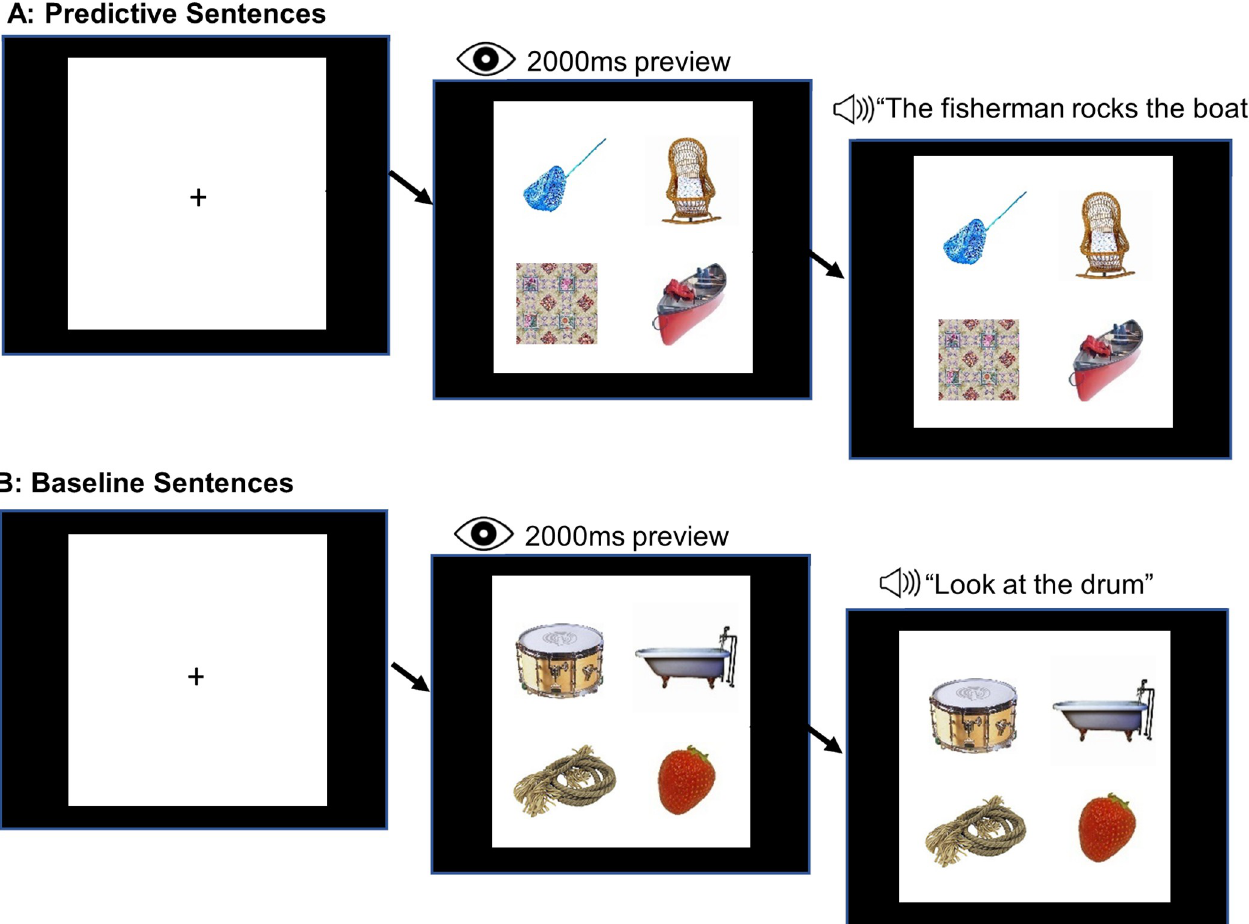
Fig 1. A schematic of the trial sequence, (A) for predictive sentences and (B) for baseline sentences. The left-most panel depicts the fixation cross, which participants had to fixate in order to launch the trial. The middle panel depicts the preview period when participants simultaneously previewed the four items. The right-most panel shows the screen layout when the sentence audio began. Images remained onscreen for the full duration of the sentence. Images were displayed in a balanced quadrant in the center of a white background, with ~1.5 inches between images horizontally, ~0.5 inches between images vertically, and ~1 inch between the edge of the image and the edge of the white portion of the screen. Stimuli images displayed in Fig 1 are similar but not identical to the original images and are therefore for illustrative purposes only. Pool net and strawberry reprinted from Brodeur, Dionne-Dostie [117] under a CC BY